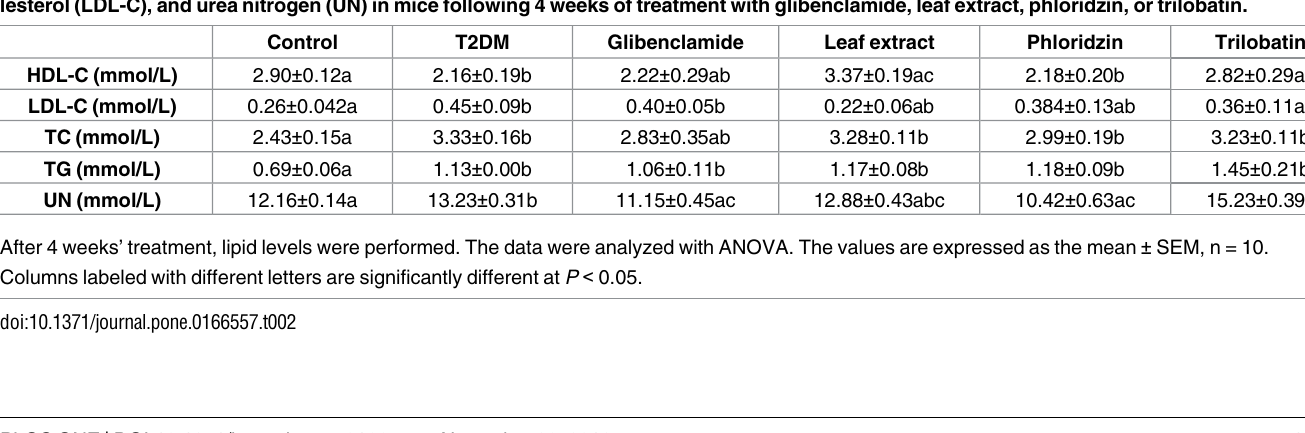
Table 2. Lipid levels, including total cholesterol (TC), triglyceride (TG), high-density lipoprotein cholesterol (HDL-C), low-density lipoprotein cho- lesterol (LDL-C), and urea nitrogen (UN) in mice following 4 weeks of treatment with glibenclamide, leaf extract, phloridzin, or trilobatin.